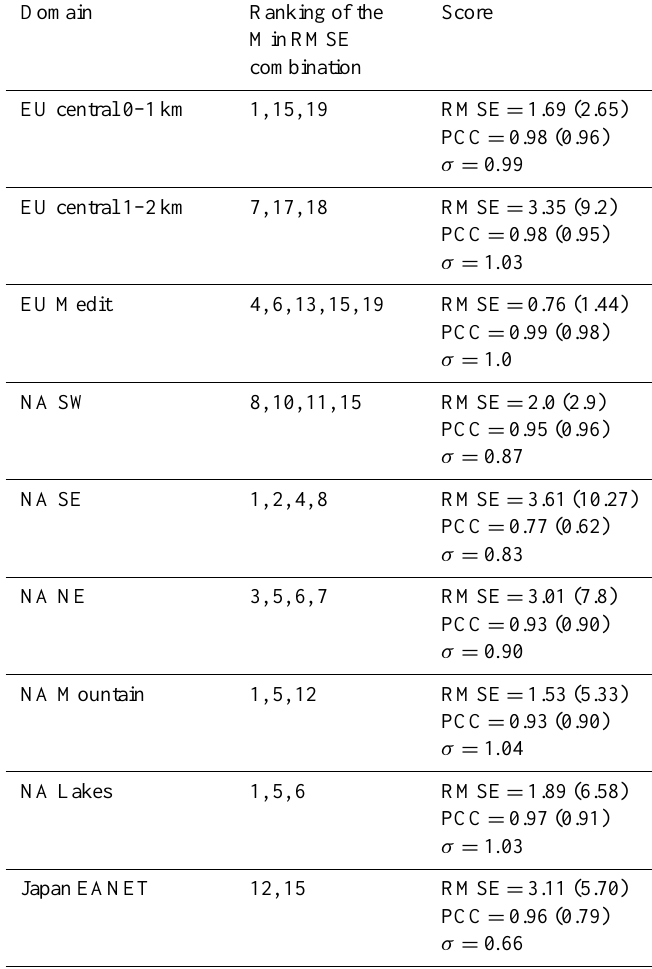
Table 2. RMSE ranking and scores of the reduced MM ensemble mean for the subregions object of the analysis (RMSE: root mean square error; PCC: Pearson correlation coefficient; σ : ratio of the modelled to the observed standard